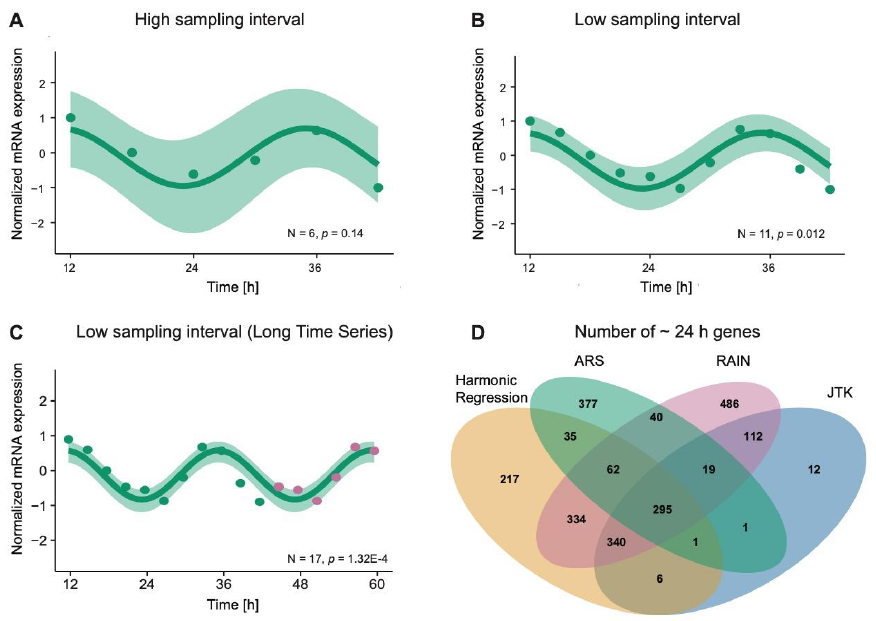
Figure 3. The impact of experimental design and computational algorithm of choice for the assessment of circadian rhythmic expression. Fitted oscillation curves (green lines) together with the experimental values (full circles) were plotted using harmonic regression for BMAL1 (in SW480 cells, E-MTAB-7779). ( A ) Normalized time-series expression for BMAL1 with a low temporal resolution (N = 6; 6 h sampling interval). ( B ) Normalized time-series expression for BMAL1 as measured experimentally in the time series used (N = 11; 3 h sampling interval). ( C ) Normalized time-series expression for BMAL1 duplicating the data points (pink full circles) between 21–36 h (N = 17; 3 h sampling interval). The green area marks the confidence area of the harmonic regression fitted to the data for 24 h rhythmic expression. ( D ) Venn diagram for the visualization of the intersection of 24 h rhythmic expression detected by RAIN, JTK, Harmonic regression and ARS.